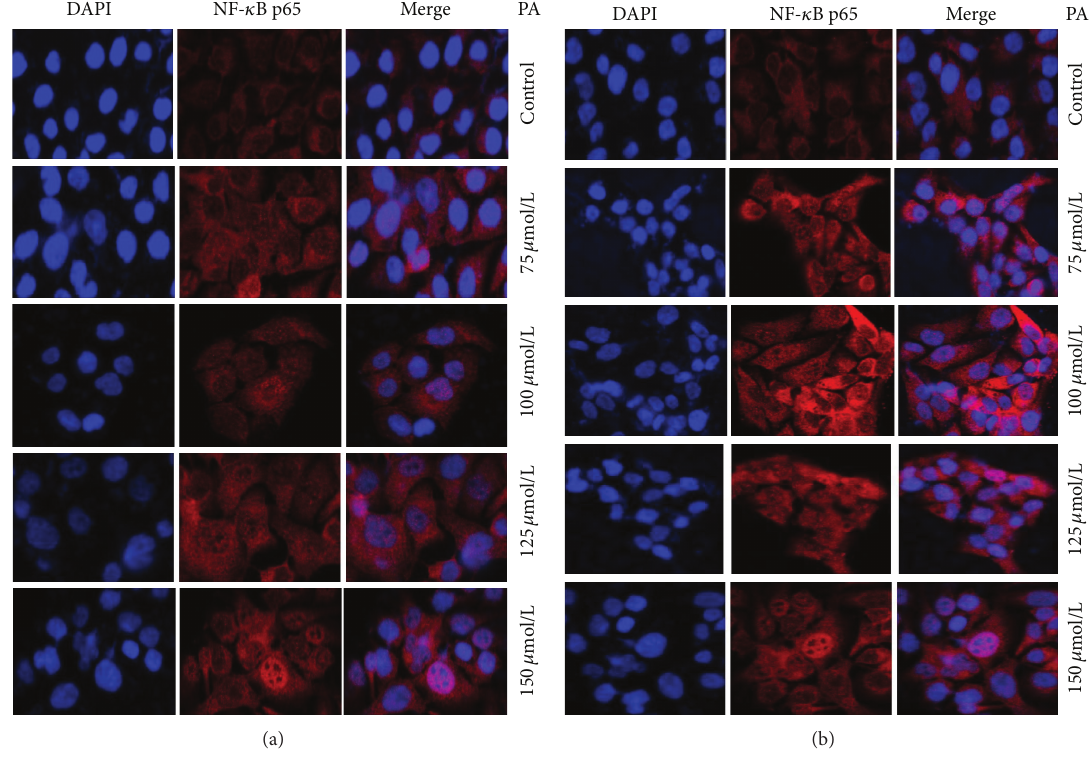
Figure 2: PA-induced nuclear translocation of NF- 𝜅 B p65 subunit in HaCaT cells immediately after the treatment and 24 hours after the PA depletion. Keratinocytes were untreated or treated with PA (75, 100, 125, and 150 𝜇 mol/L) for 24 hours under serum-free conditions. Immunostaining was performed with specific mouse anti-p65 antibody followed by Cy3-conjugated mouse anti-rabbit immunoglobulins (red) immediately after the treatment (a) and 24 hours after the PA depletion (b). Images are representative of three independent